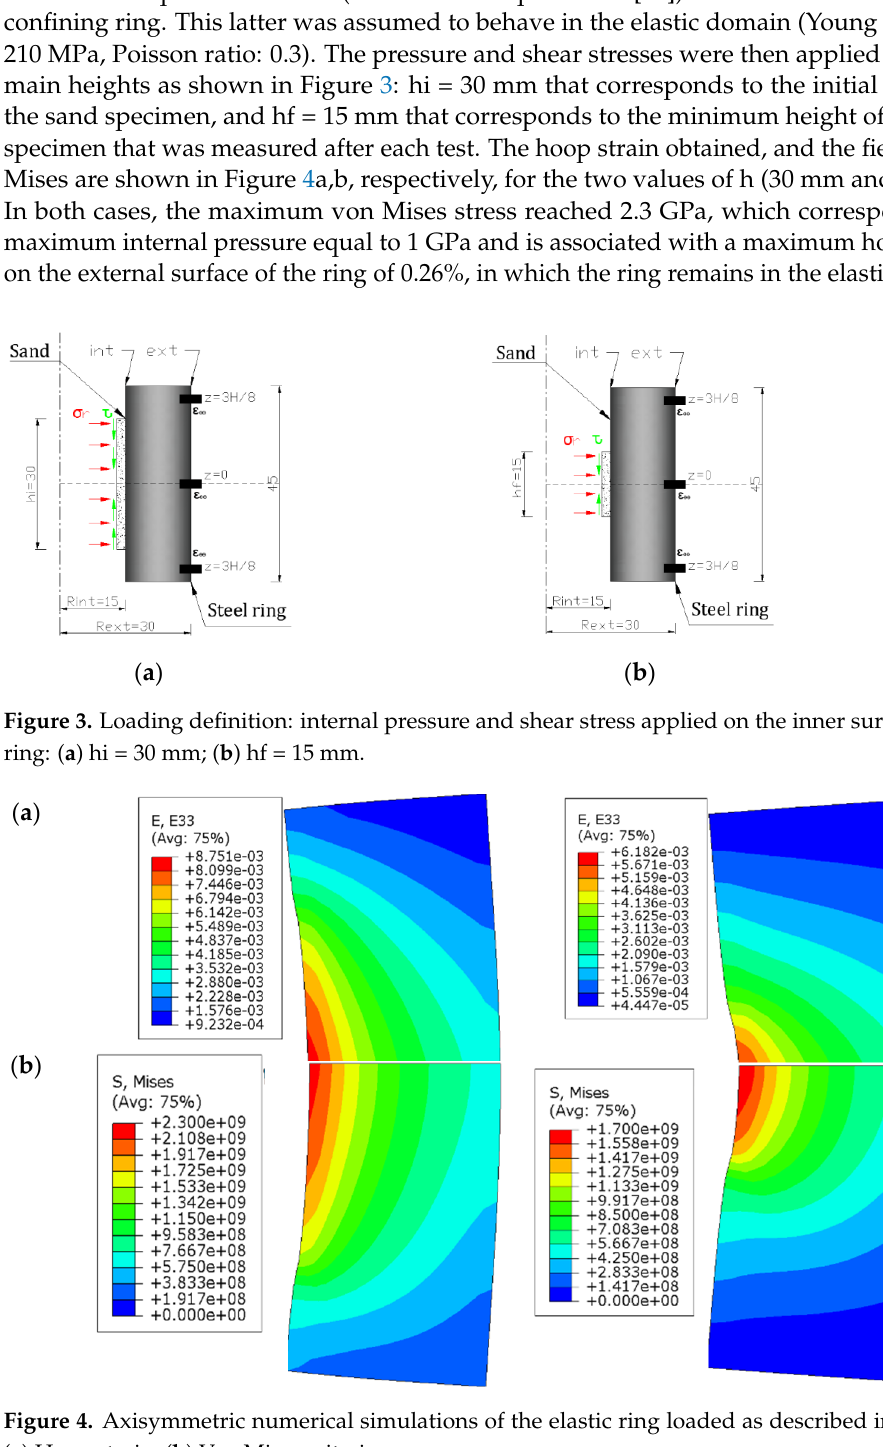
Figure 4. Axisymmetric numerical simulations of the elastic ring loaded as described in Figure 3: ( a ) Hoop strain; ( b ) Von Mises criterion. ( a ) Hoop strain; ( b ) Von Mises